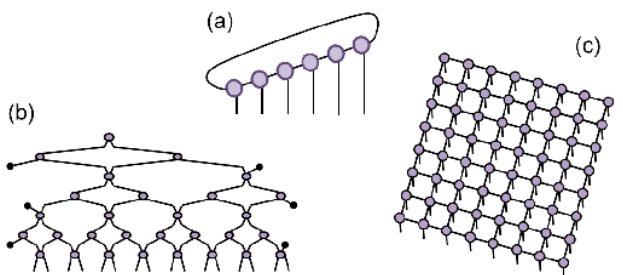
Figure 1. Three well-studied tensor networks. (a) Matrix Product State for (1+1)-dim gapped systems. (b) MERA network for in (1+1)-dim gapless systems. (c) Projected Entangled Pair States for (2+1)-dim systems. Picture courtesy of